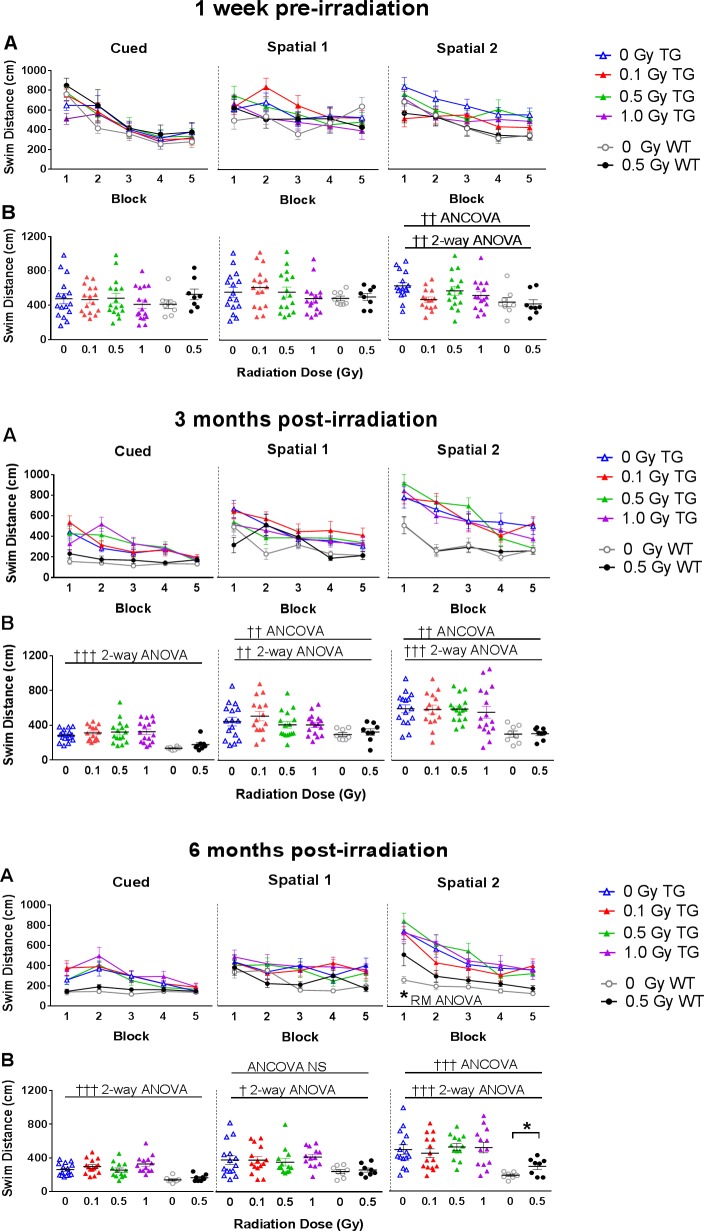
WM performance of TG and WT mice at baseline, 3 and 6 months post-irradiation.(A) Swim distance for each of the 5 blocks during Cued, Spatial 1 and Spatial 2 tests. (B) Swim distance averaged over the blocks. Upper panels A, B: Both the TG and WT mice exhibited gradually reduced swim distances in five successive blocks of each, Cued, Spatial 1, and Spatial 2 tests, suggesting that all groups were able to learn the task of locating the platform, which was most noticeable during baseline (pre-irradiation) testing. However, already at this time point (~2.5 months old) the WT mice performed significantly better than TG mice on the Spatial 2 (reversal learning) test. Middle and bottom panels A, B: At 3 and 6 months post-irradiation, we observed consistent genotype-related differences between TG and WT mice as the TG mice swam significantly longer in the Cued, Spatial 1 and Spatial 2 tests. When controlling for decrements in swim distance on the Cued test with ANCOVA at 6 months, the increased swim distance in the Spatial 2 test was still significant, which confirmed that the genotype-related decrement in TG mice are due to impaired hippocampus-dependent spatial memory. No significant radiation-induced differences were observed among the TG mice at any post-irradiation time point. However, irradiated WT mice searching for the relocated platform swam significantly longer distance during the Spatial 2 test at 6 months than the non-irradiated WT controls. This effect was most prominent during block 1 of that test, indicating radiation-impaired reversal learning in WT mice only (RM ANOVA; bottom panel A, right). TG mice: N = 12–15 mice/radiation group; WT mice: N = 8 mice/radiation group. Statistical analyses: Repeated measures ANOVA and ANCOVA, Open line—genotype effects ††† p<0.001, †† p<0.01, † p<0.05; Closed line—radiation effects * p<0.05. Data represent means ± SEM.